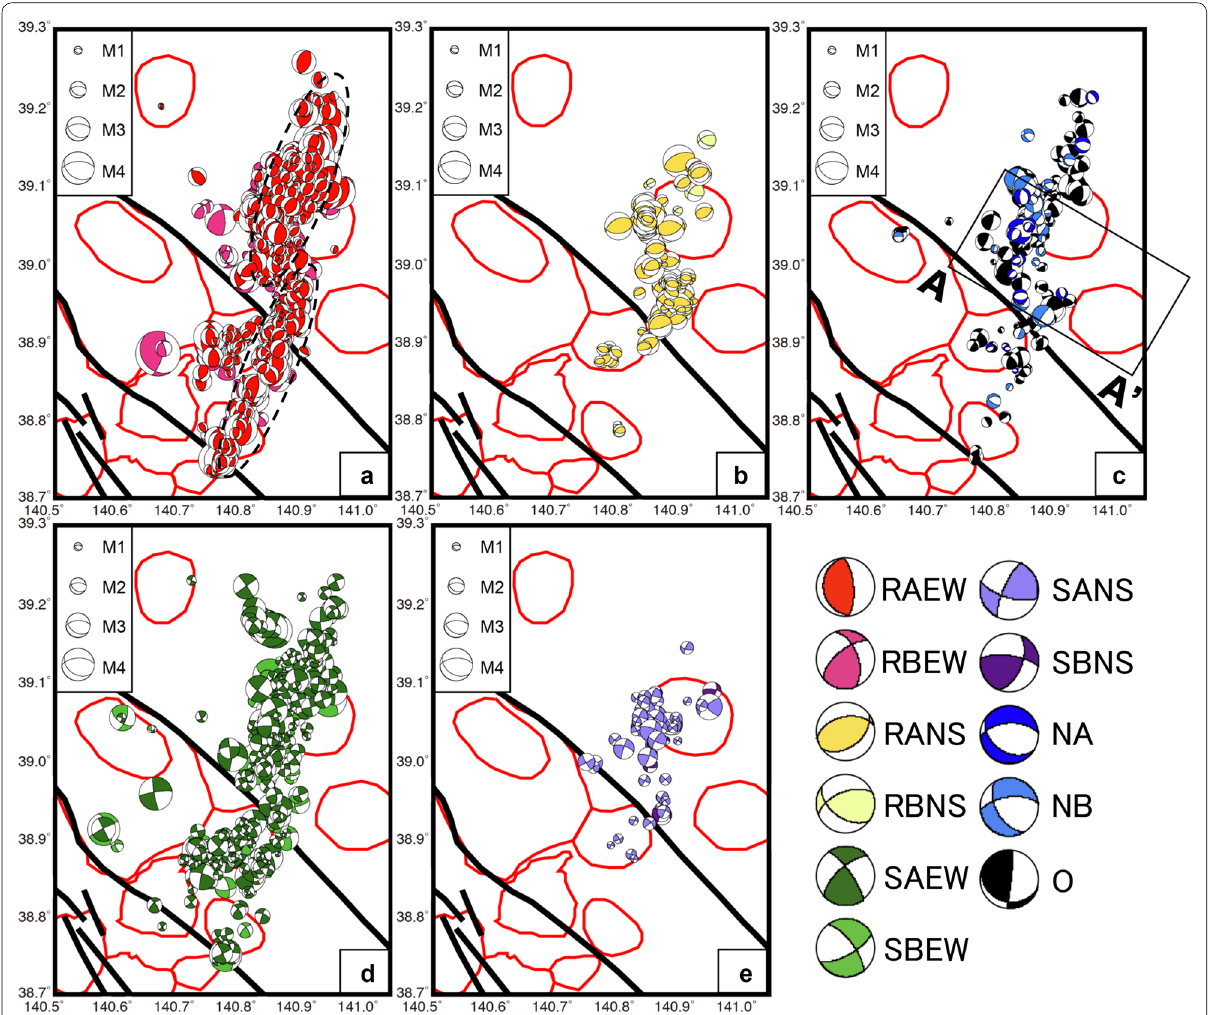
Fig. 3 Focal mechanism distributions. Focal mechanisms of earthquakes for the period from 14 June 2008 to 30 September 2008 are shown. a Distribution of reverse-faulting events with E–W compression composing subgroups A (RAEW) and B (RBEW). Dashed black ellipses indicate northern and southern clusters. b Distribution of reverse-faulting events with N–S compression composing subgroups A (RANS) and B (RBNS). c Distribution of normal-faulting events composing subgroups A (NA) and B (NB), and other events (O). The black rectangle indicates the location of the cross sections in Fig. 4. d Distribution of E–W-compressional strike-slip events composing subgroups A (SAEW) and B (SBEW). e Distribution of N–S-compressional strike-slip events composing subgroups A (SANS) and B